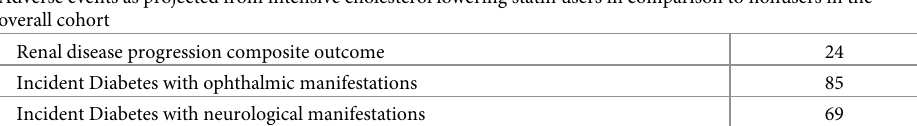
Stroke 291 Revascularization 131 Intensive lowering of choesterol